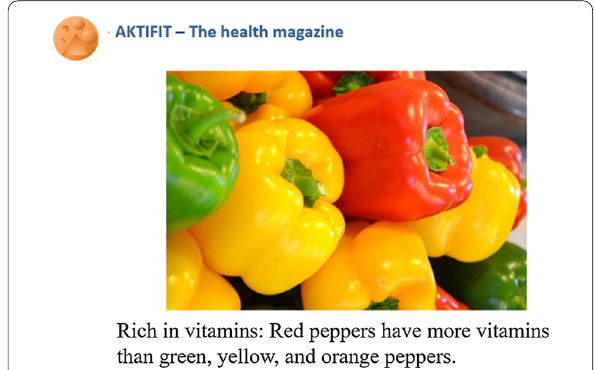
Fig. 3 Exemplary statement in the fake-source condition and picture condition. Note that in the original study the sources and statements were presented in German. The picture displayed is under public domain license (CC0) and is from https ://pixni o.com/de/pflan